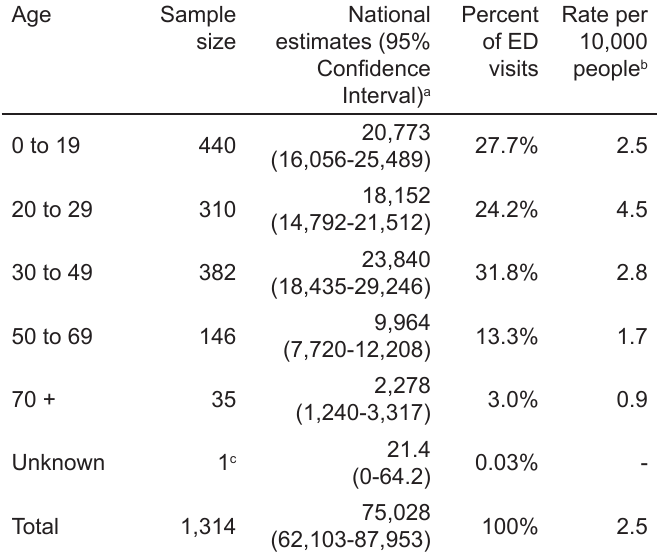
Table 3. Age breakdown of motor vehicle crash-associated eye injuries treated in U.S. emergency departments, 2001-2008.